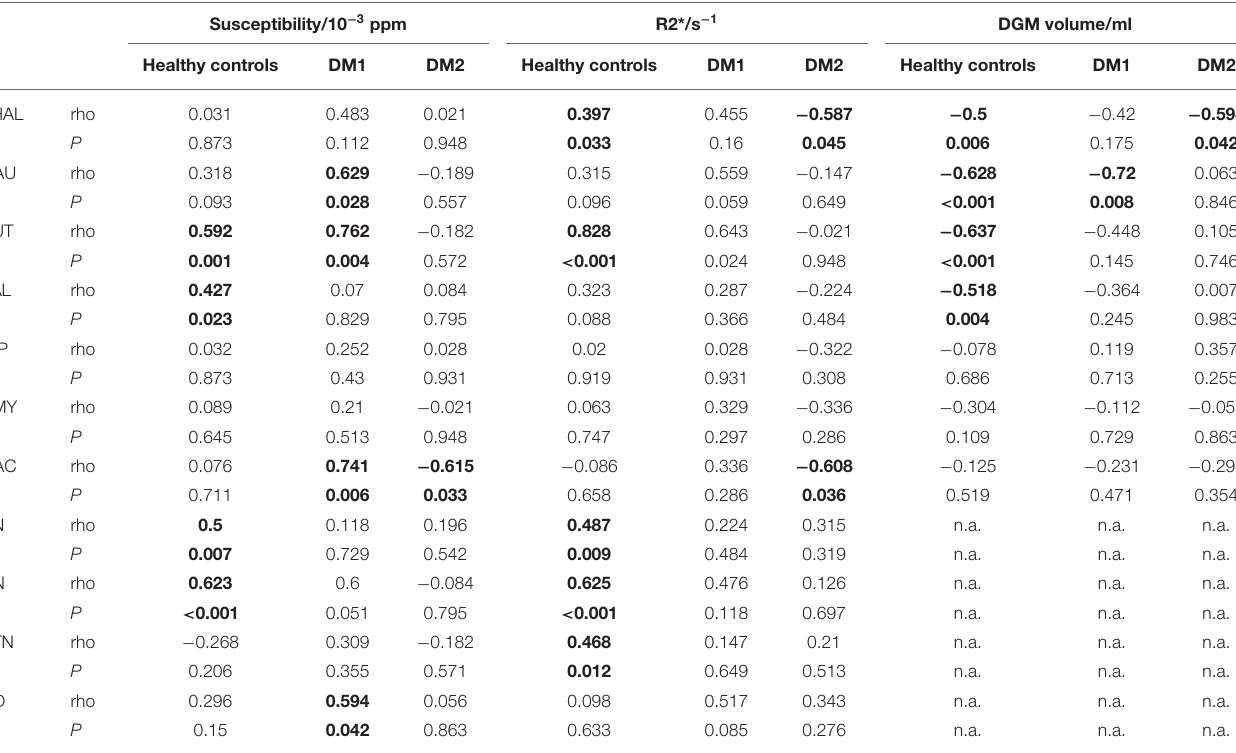
TABLE 3 | Spearman correlations of magnetic susceptibility, R2 * , and DGM volumes with age for DM1, DM2, and healthy